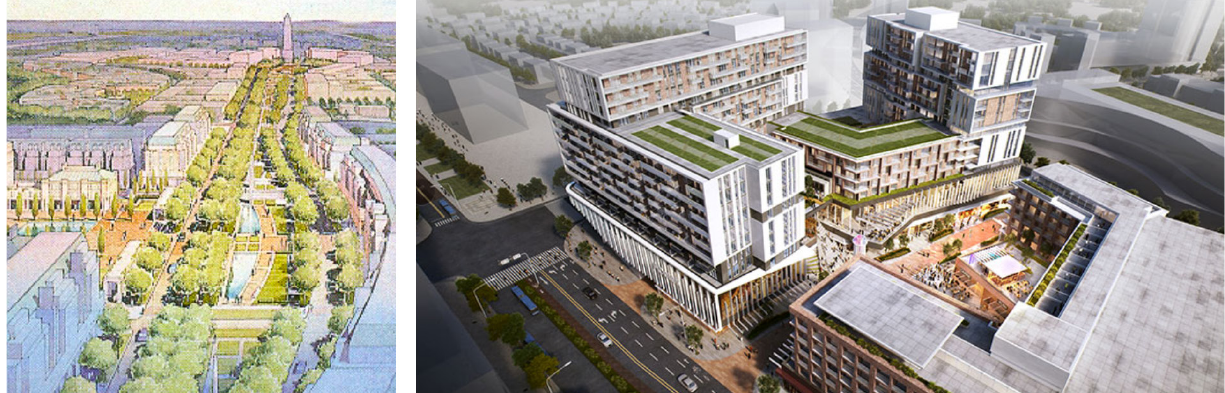
Figure 5. Left: New urbanist streetscape rendering. Source: Courtesy of City of Markham. Right: Contemporary streetscape rendering for Gallery Square Project in Downtown Markham. Source: Remington Group (2020c). and infrastructure development coming together” (P27).